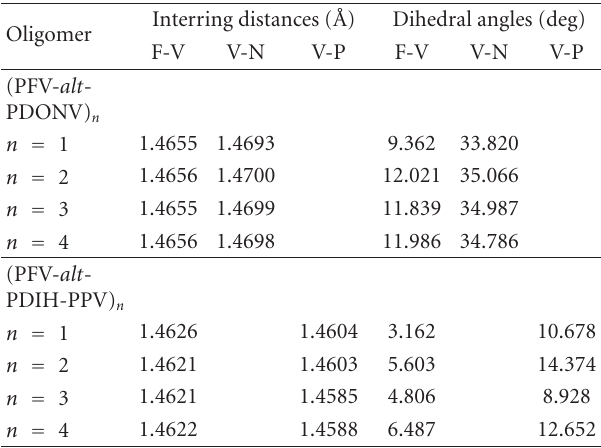
Table 1: Selected interring distances and dihedral angles of PFV- alt -PDONV and PFV- alt -PDIH-PPV ( n = 1–4) obtained by B3LYP/6-31G(d,p).